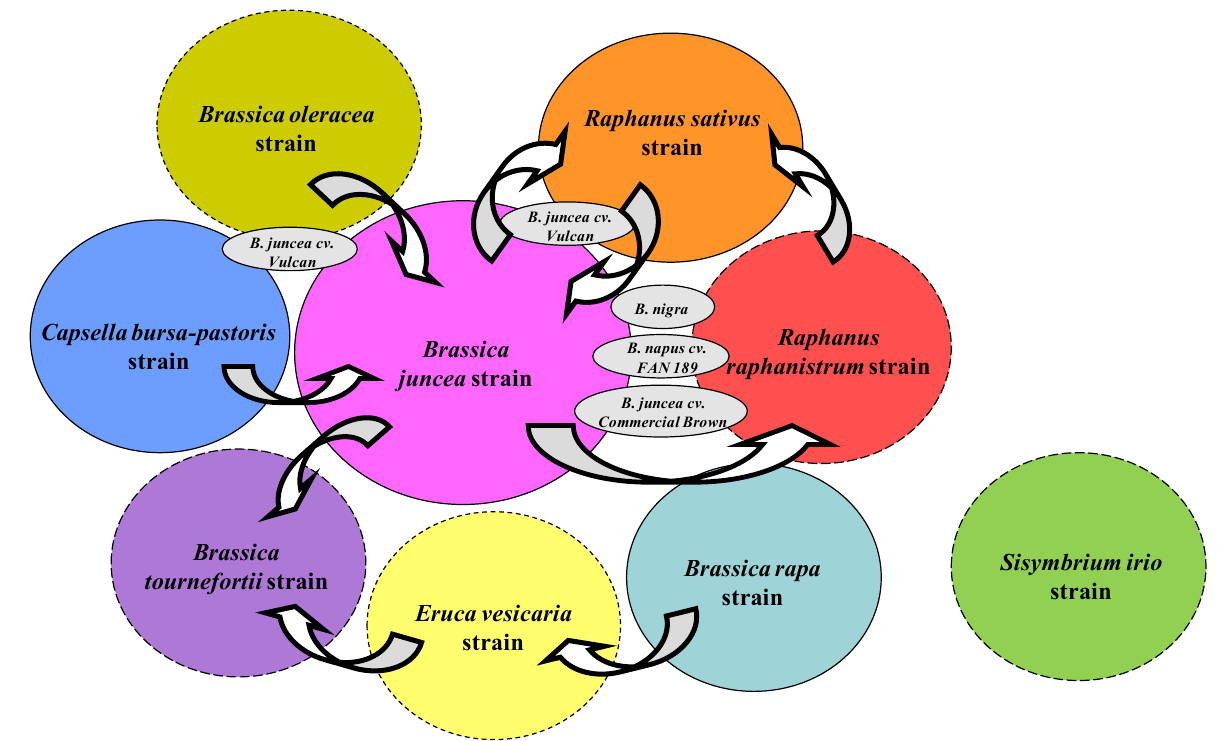
Figure 2. Host specificity and variability in virulence of Albugo candida strains collected from nine different cruciferous host species in Western Australia (Kaur, 2010). Circles indicate host of origin of strain and the arrows indicate the susceptibility of the host to the isolate. Dotted circles indicate the isolates reported in W.A. for the first time. Sisymbrium irio strain failed to cause disease on all hosts tested and vice